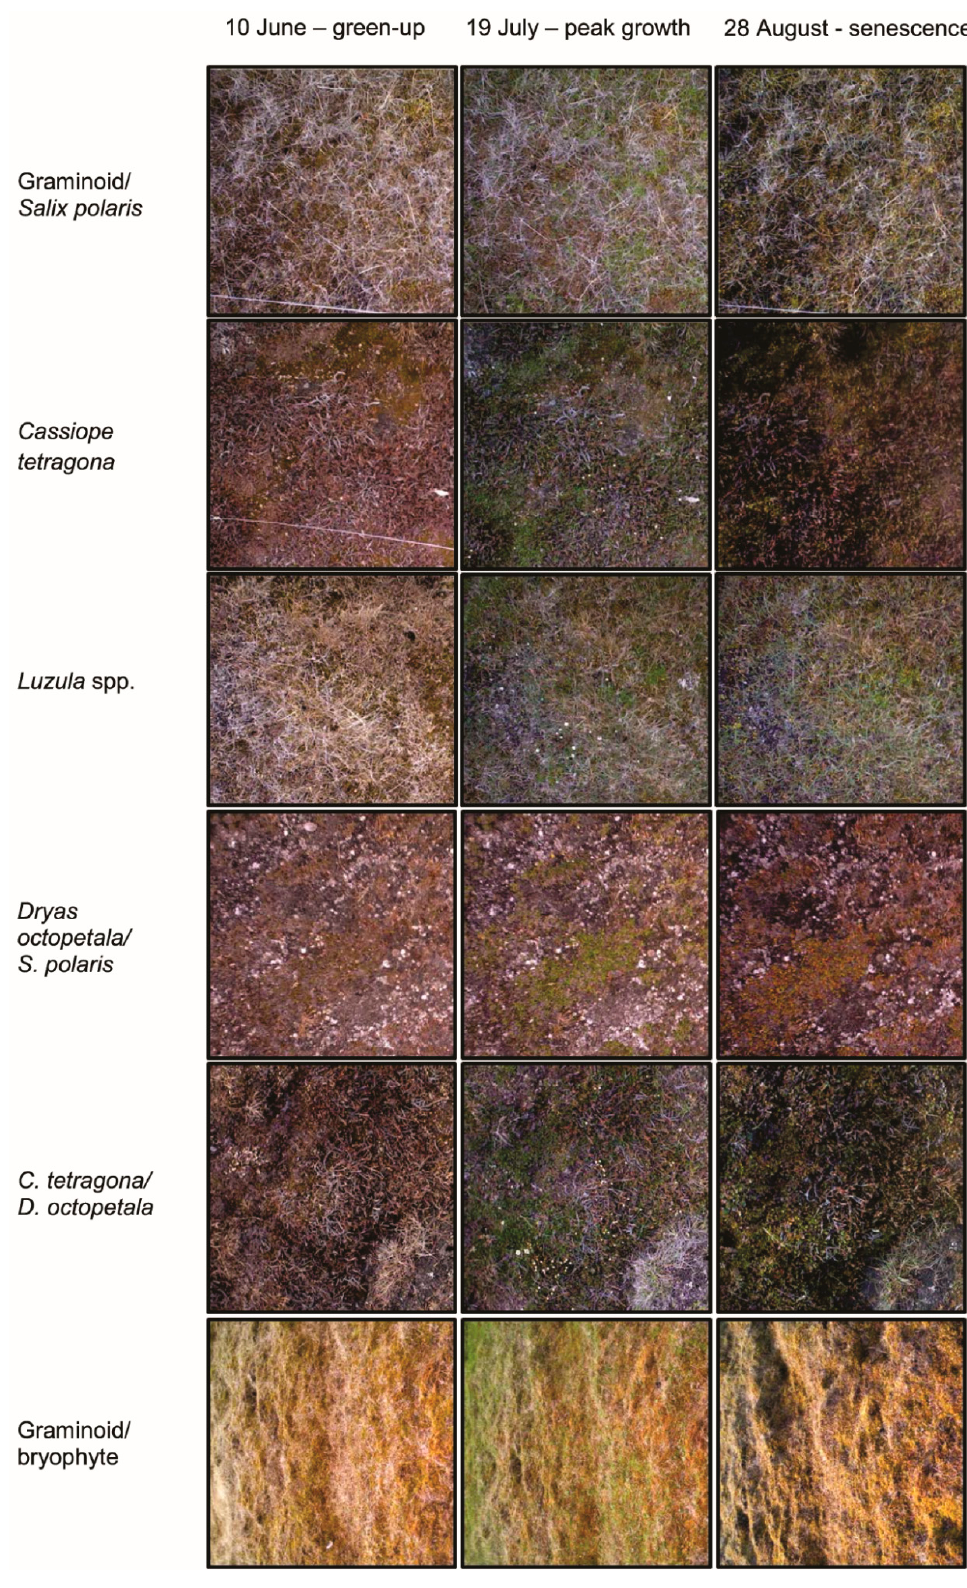
Figure 3. RGB camera images of six High Arctic plant species/groups from Svalbard during plant green-up (10 June DOY 160), peak plant growth (19 July DOY 200) and senescence (28 August DOY 240).